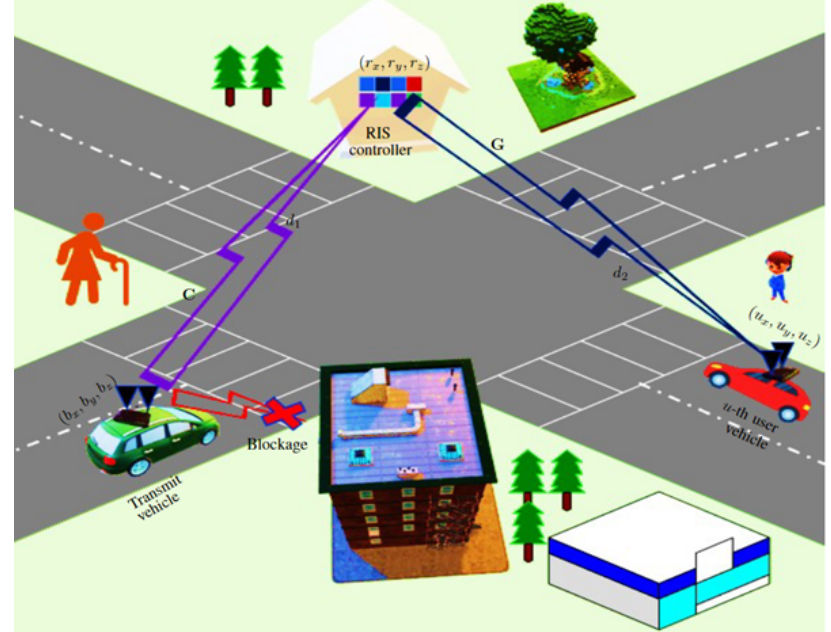
Figure 1. System model is illustrated by RIS-assisted V2V communications.